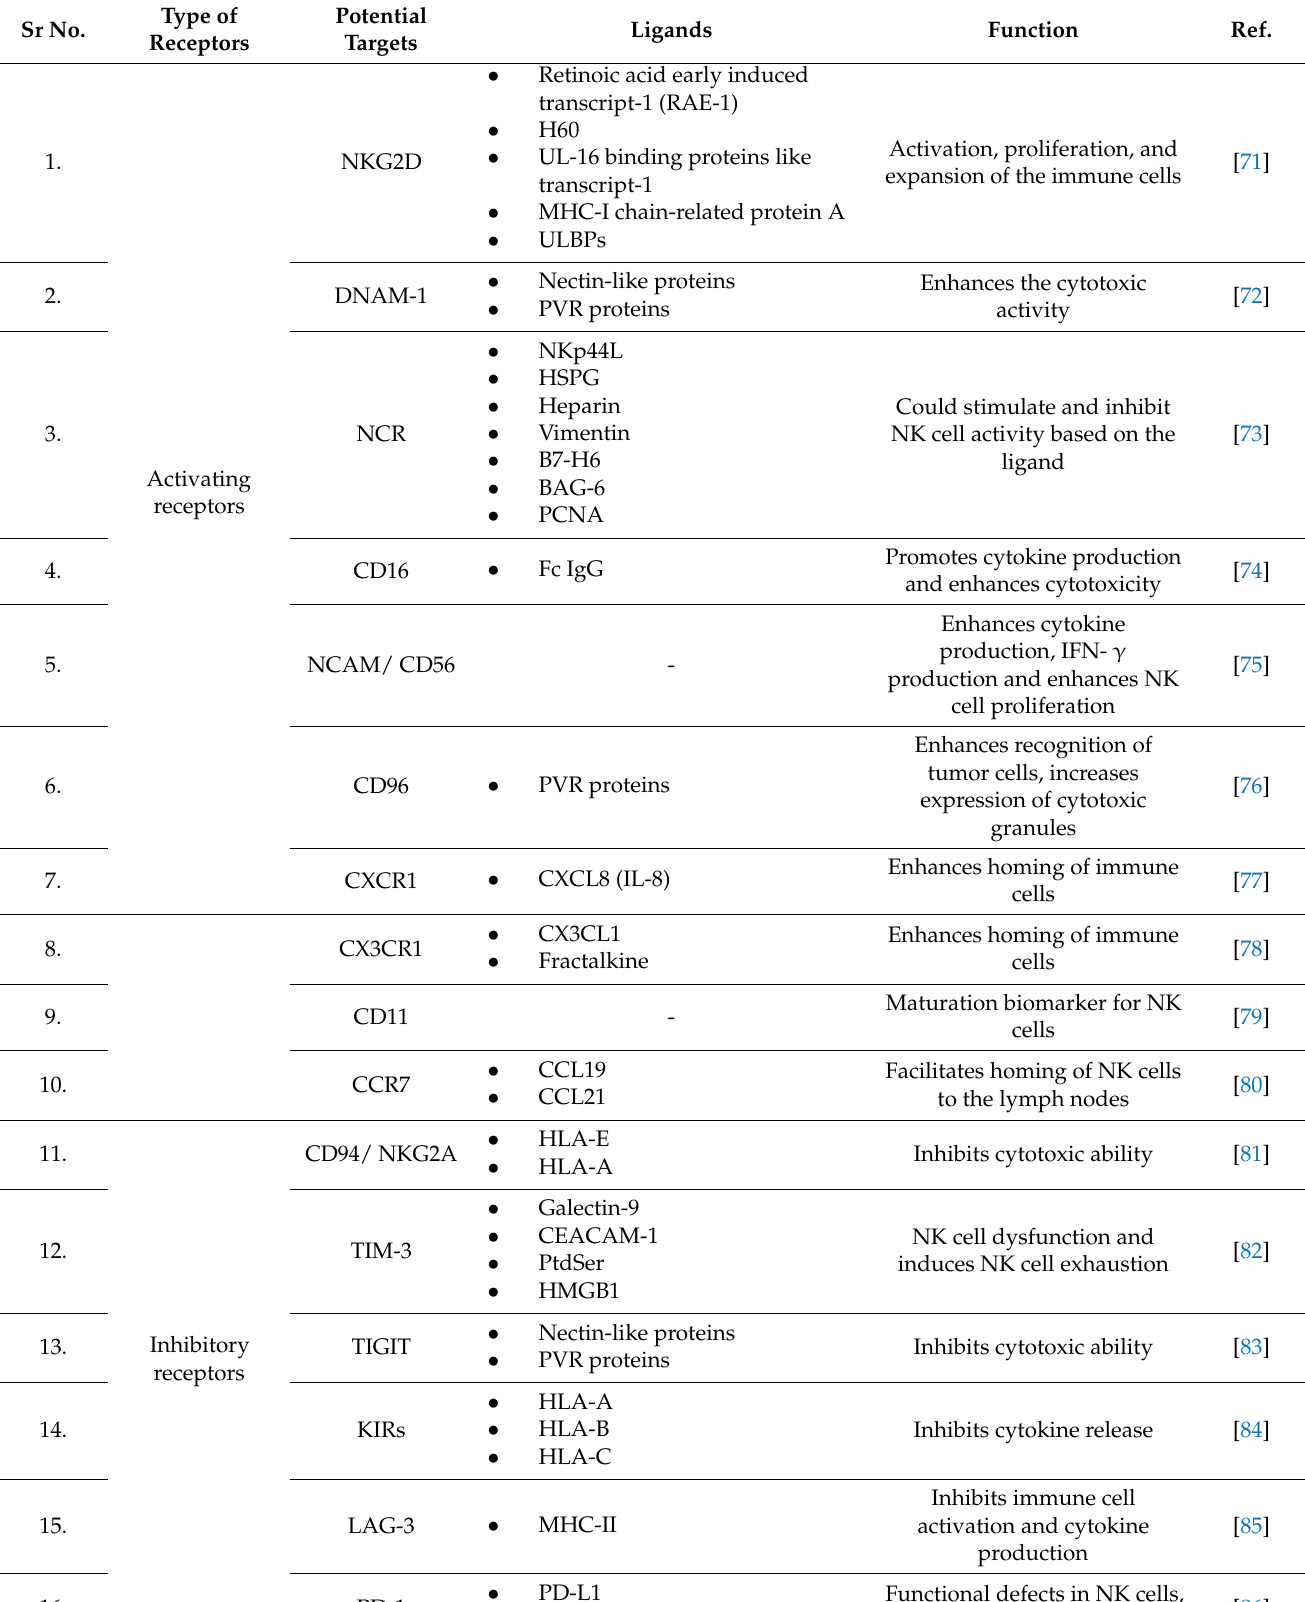
Table 1. Comprehensive information on potential NK cell receptors for targeting NK cell-based immunotherapy. Ligands Function